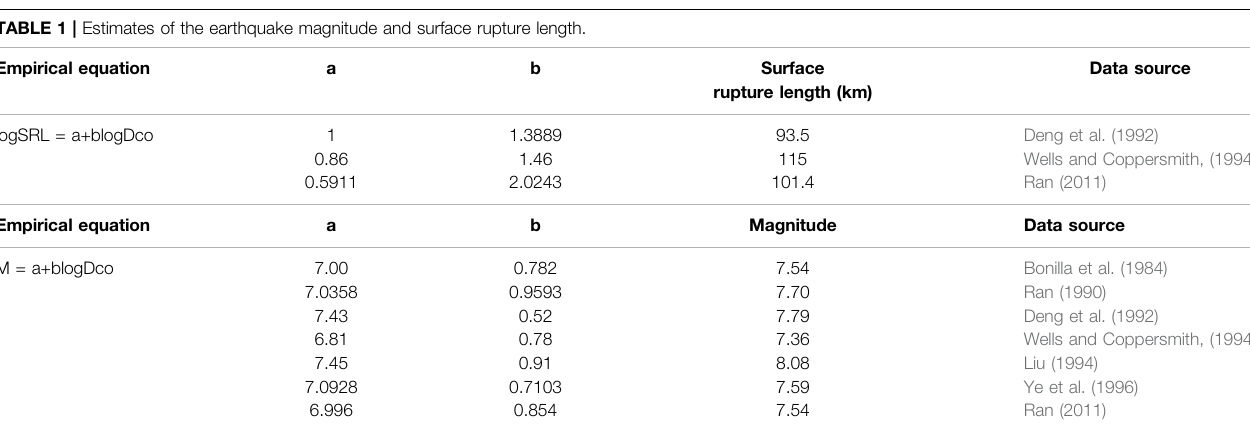
TABLE 1 | Estimates of the earthquake magnitude and surface rupture